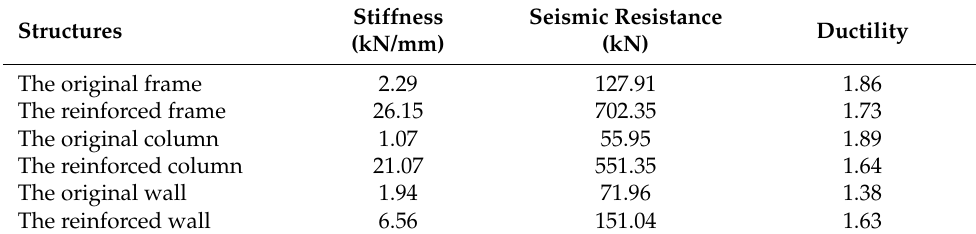
Table 5. Stiffness, seismic resistance, and ductility of the